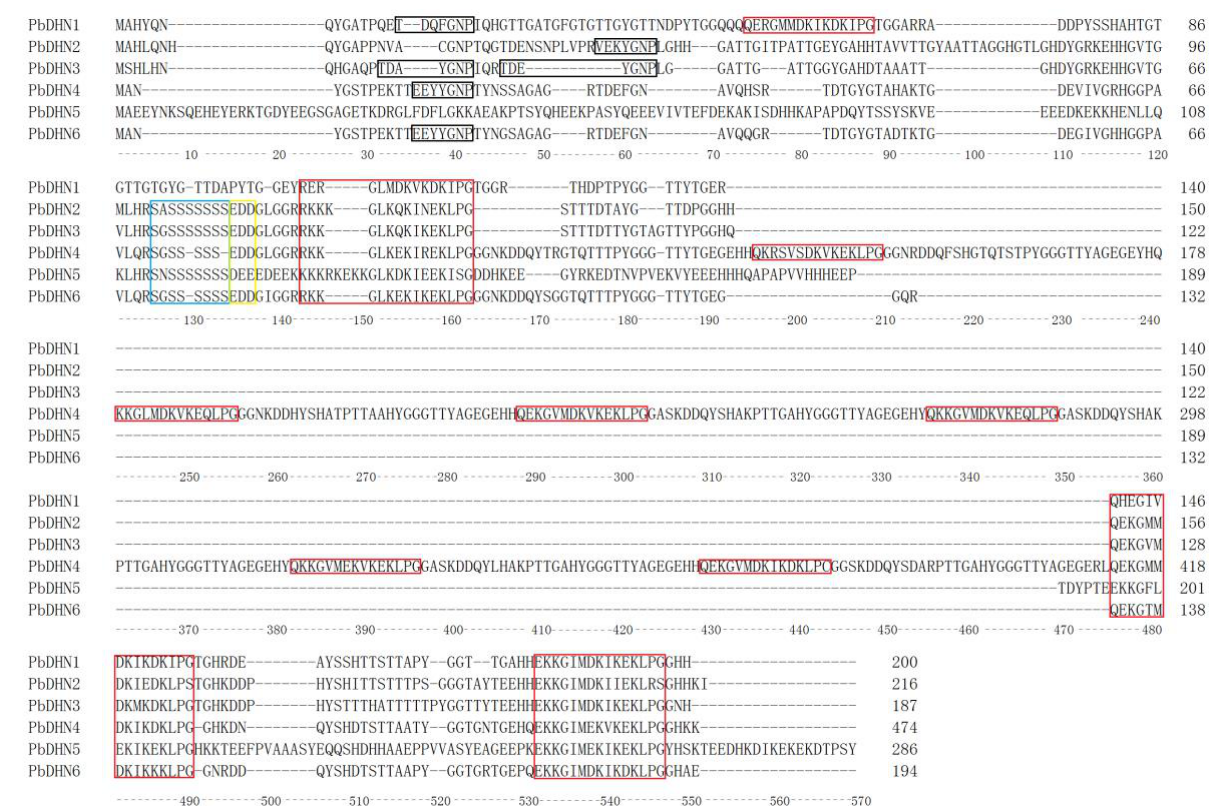
Table 3. Characteristics analysis of PbDHNs .